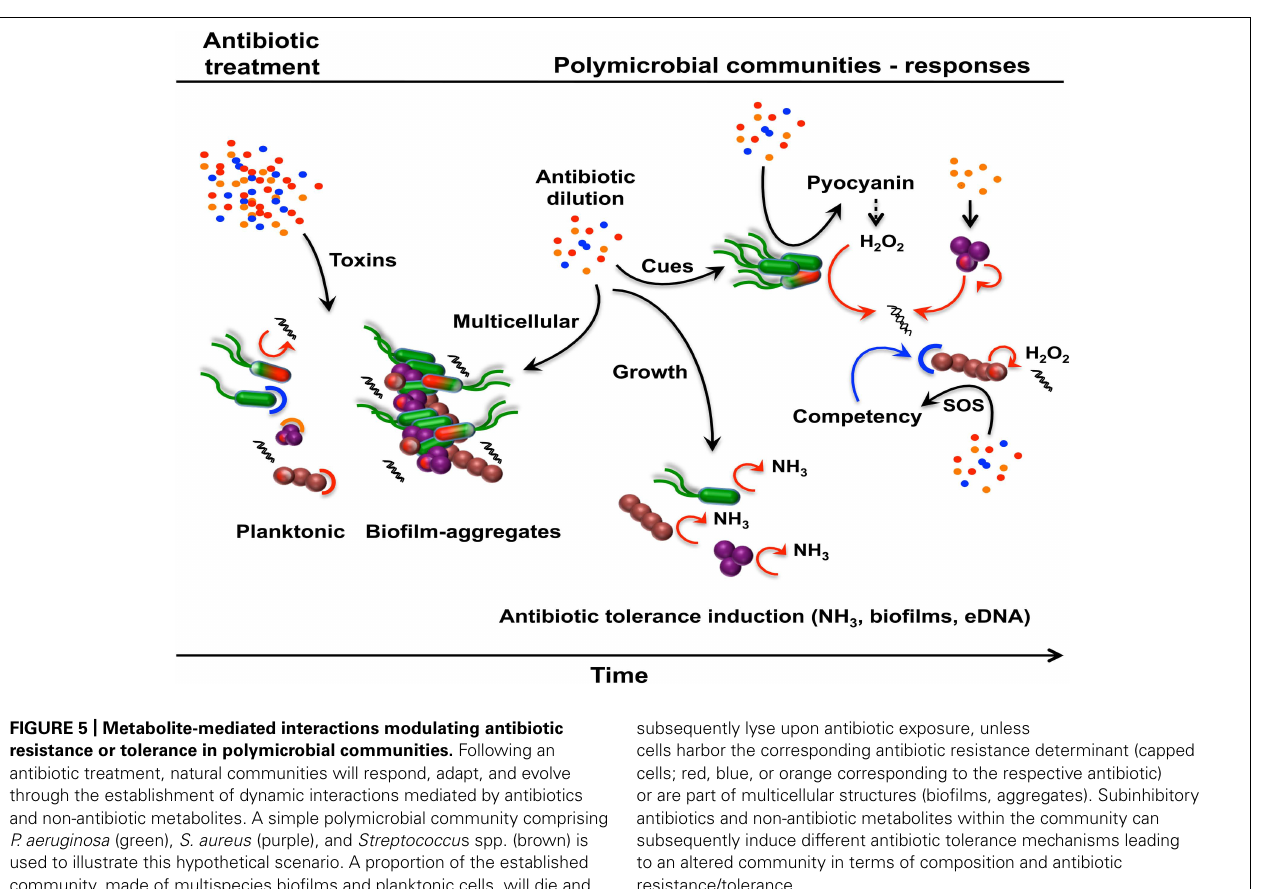
subsequently lyse upon antibiotic exposure, unless cells harbor the corresponding antibiotic resistance determinant (capped cells; red, blue, or orange corresponding to the respective antibiotic) or are part of multicellular structures (biofilms, aggregates). Subinhibitory antibiotics and non-antibiotic metabolites within the community can subsequently induce different antibiotic tolerance mechanisms leading to an altered community in terms of composition and antibiotic